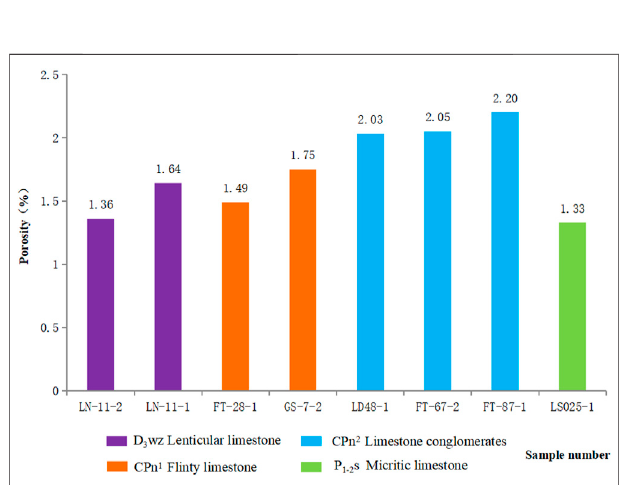
FIGURE 9 | Porosity difference of limestone in different strata of Upper Paleozoic in the Qiannan area.